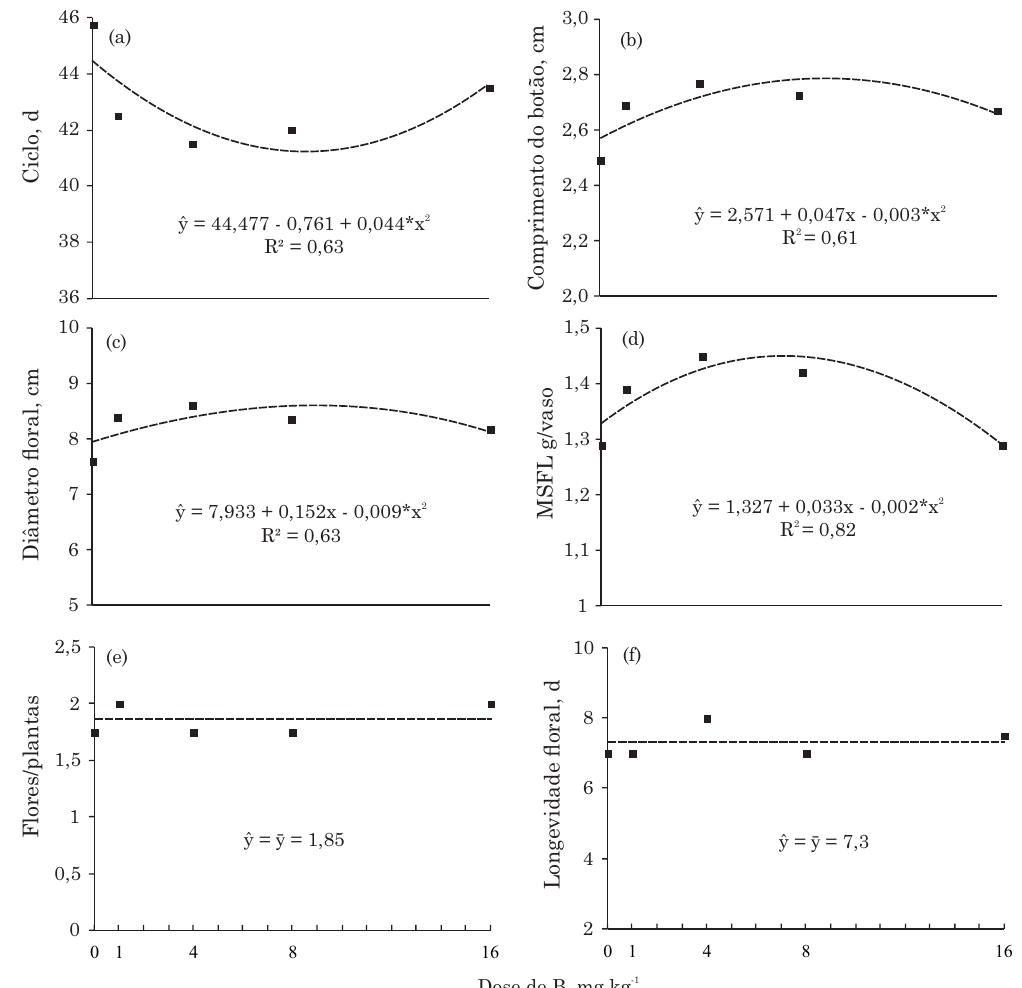
Figura 2. Número de dias para o florescimento (ciclo) (a), comprimento do botão (b), diâmetro floral (c), produção de matéria seca de flores (d), número de flores por planta (e) e longevidade floral (f) de roseira (cv. Shiny Terrazza ® ), em função da aplicação de doses de B no substrato. *: Significativo a 5 % pelo teste t.